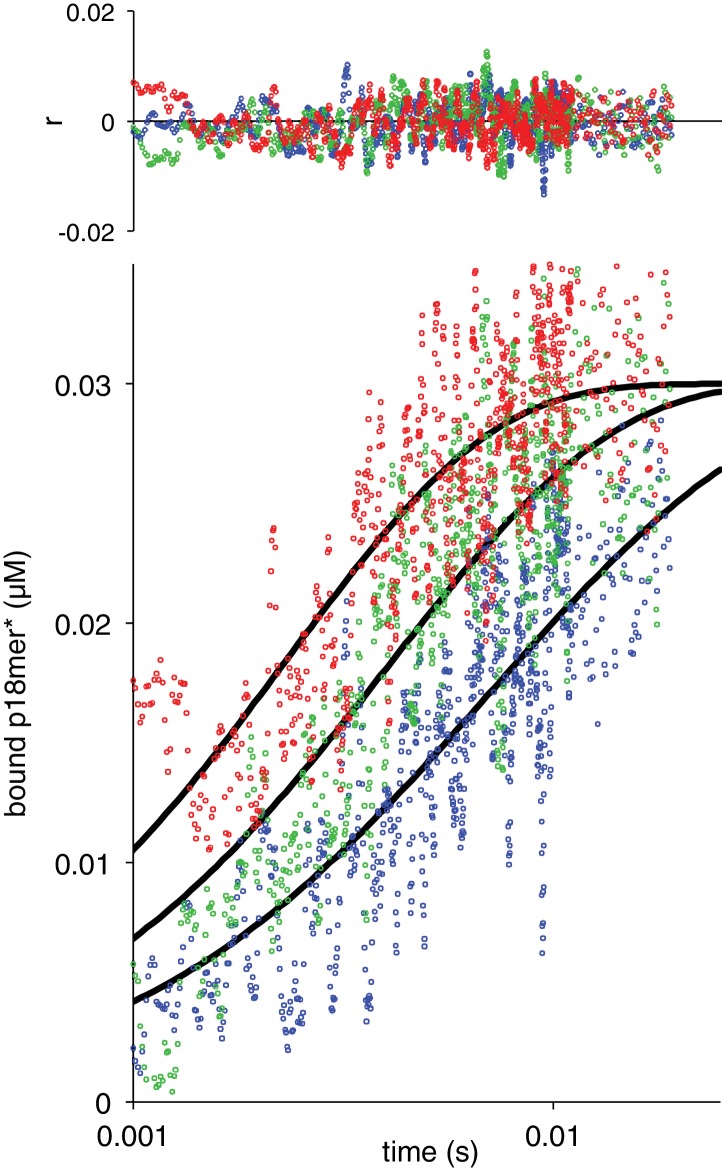
Association of ΔZn1 with p18mer*.Global fits of the kinetic model in Scheme 1 for three representative protein concentrations: 42 nM in blue, 72 nM in green, 120 nM in red. Residuals for the three concentrations are shown overlaid in the corresponding colors above.10.7554/eLife.37818.007Figure 2—figure supplement 1—source data 1.Association of ΔZn1 with p18mer*.